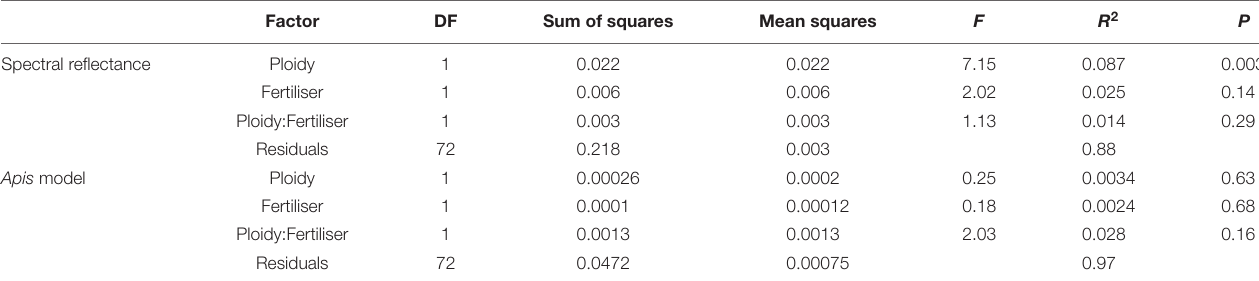
FIGURE 1 | Drawing of Chamerion angustifolium with the three floral measures depicted (A) and (B) the variation in flower size measures of diploid (D) and tetraploid (T) plants. Petal measurements were taken from the lower right petal of female-phase flowers. Only style length showed significant differences between diploids (white) and tetraploids (grey). Boxplots show median and the spread of the data. Illustration by Lucie Vézina. TABLE 1 | PERMANOVA results for the spectral reflectance of Chamerion angustifolium flower petals before and after application of a Apis visual sensitivity model, testing for the effects of ploidy, fertiliser during growth, and their interaction. Factor DF Sum of squares Mean squares F R 2